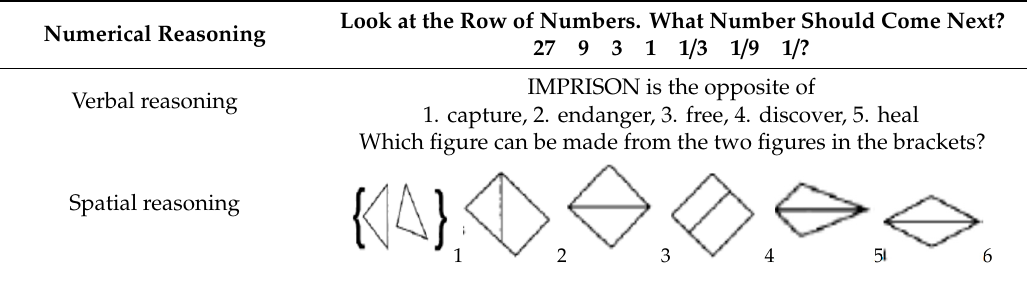
Table A1. Cognitive Skill Example Questions.